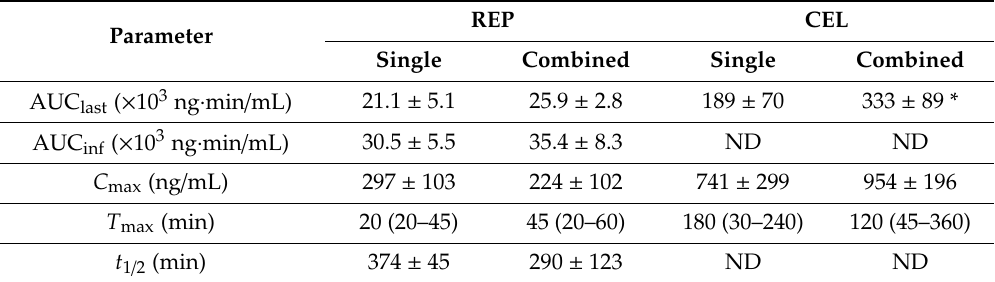
Figure 3. Plasma concentration versus time profiles of REP ( A ) and CEL ( B ) after oral administration of 0.4 mg/kg REP and 2 mg/kg CEL either alone (closed circle) or in combination (open circle) to rats. The circles and vertical bars represent means and standard deviations, respectively ( n = 5). Table 4. Pharmacokinetic parameters of REP and CEL in rats after oral administration of 0.4 mg / kg REP and 2 mg / kg CEL either alone or in combination ( n = 5).